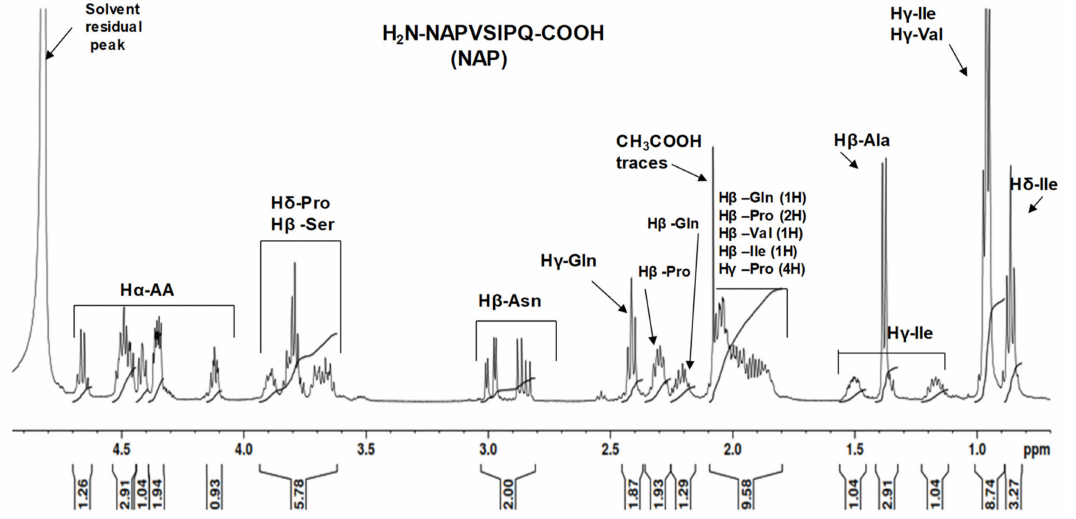
Figure 4. 1 H-NMR spectrum of NAP peptide dissolved in D 2 O